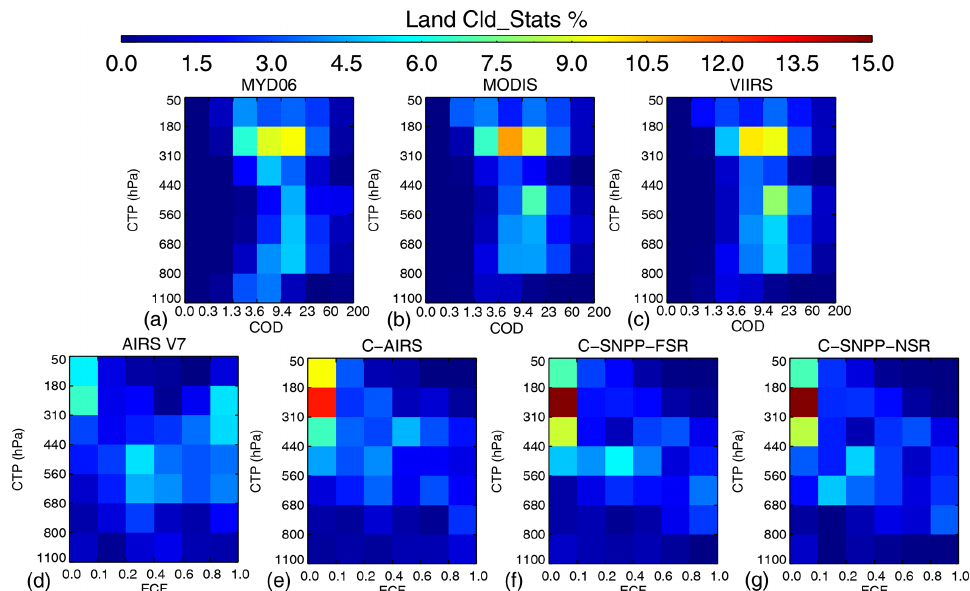
Figure 12. Similar to Figs. 11 and 10, except showing results calculated using data over land at 60 ◦ N–60 ◦ S. Sounder land fraction > 0 . 9 is used to determine land surfaces.